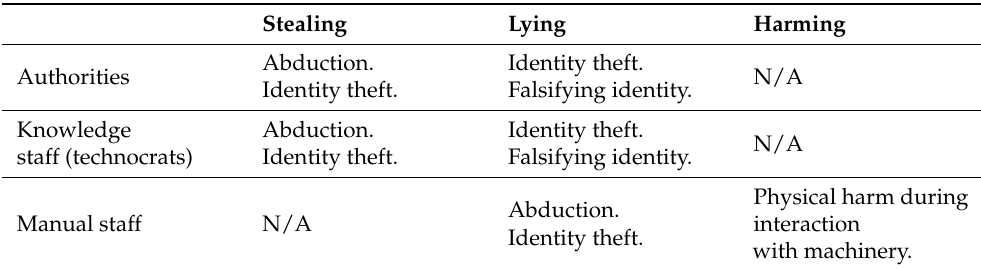
Table 7. Wrongs towards stakeholders [65]. Reprinted/Adapted with permission from Reference [65].